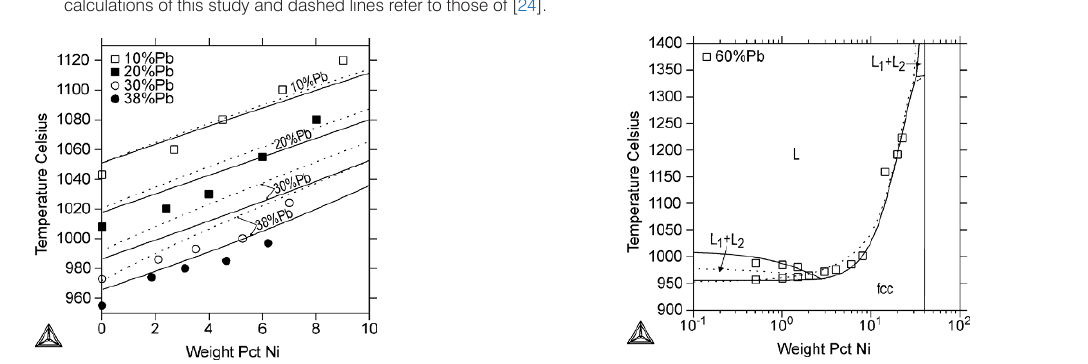
Figure 4. Calculated liquidus surfaces of the Cu-Ni-Pb system (a) and an enlarged section from the Cu-Pb side, together with experimental data points [13–16]. In Fig. 4b, the experimental data points are from the smoothed experimental data of Pelzel [15]. Solid lines refer to the calculations of this study and dashed lines refer to those of [24].